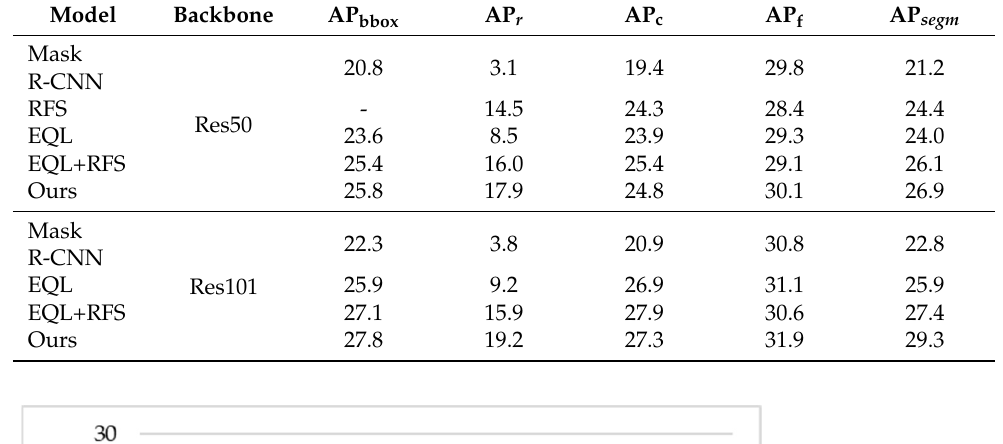
Table 3. Comparison of the results on LVIS v0.5.